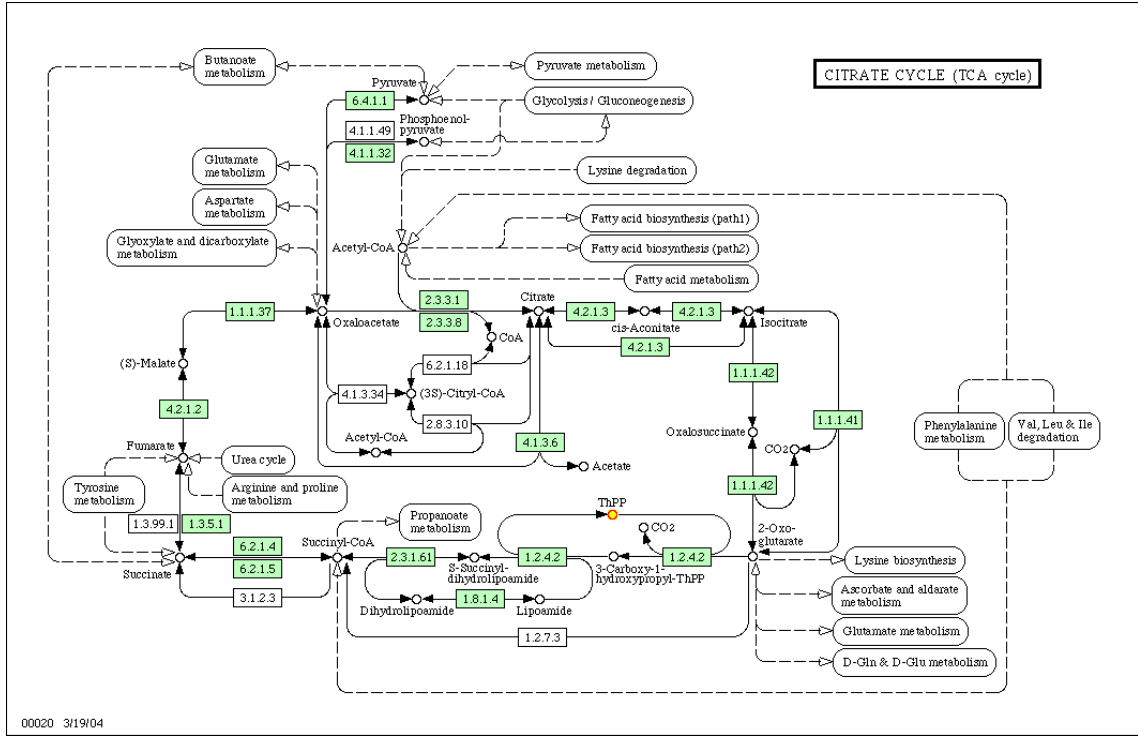
Figure 6: The figure shows a generated marked pathway-map for the selected agent Cocarboxylase which will be displayed after selecting one of the marked-maps links (see also figure 5). The example shows the human citrate cycle with the cocarboxylase (ThPP) reactant marked in